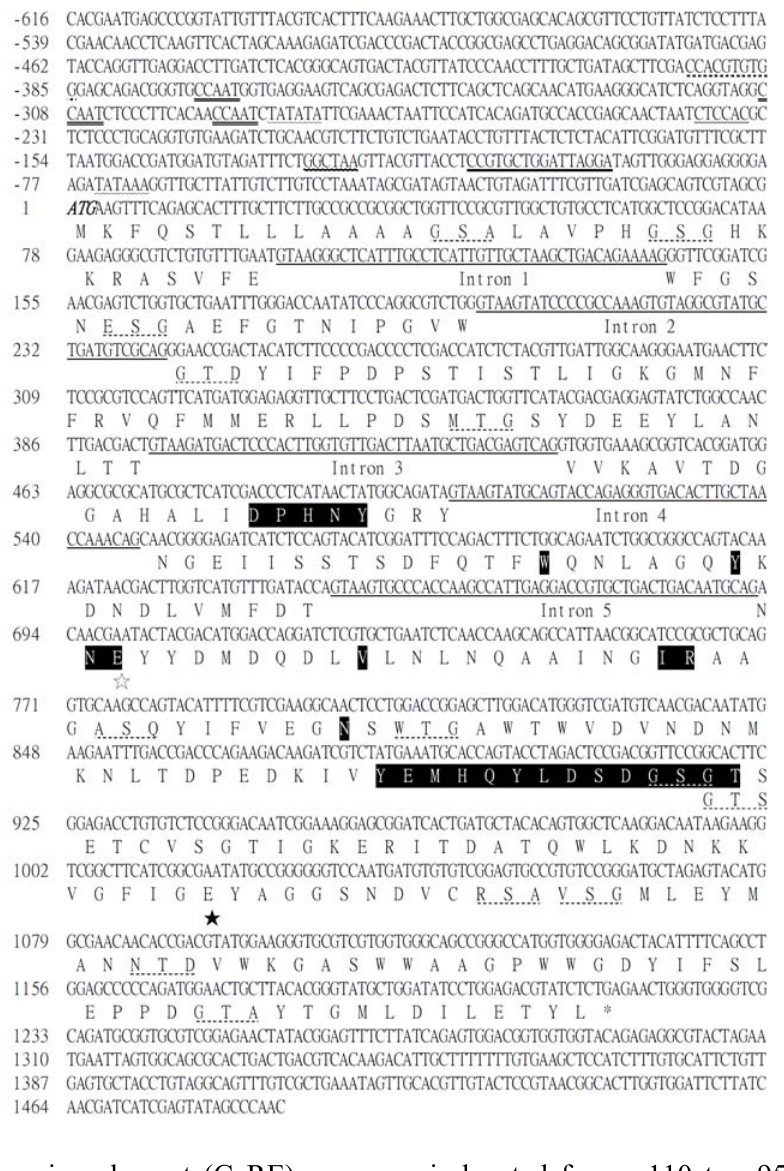
Figure 1. The nucleotide and deduced amino acid sequence of egl B. DNA sequences of intron are underlined. The start and stop cordons are shown bold italic. The putative CAAT box sequence is double-underlined. The putative TATA box sequence is